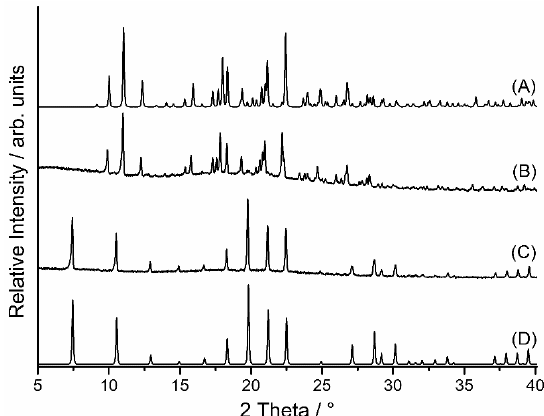
Figure 8. Calculated XRPD patterns of 1 ( A ) and 1-H 2 O ( D ). The experimental XRPD patterns of 1 ( B ); and of the product obtained after stirring this compound in water for 2 d ( C ).